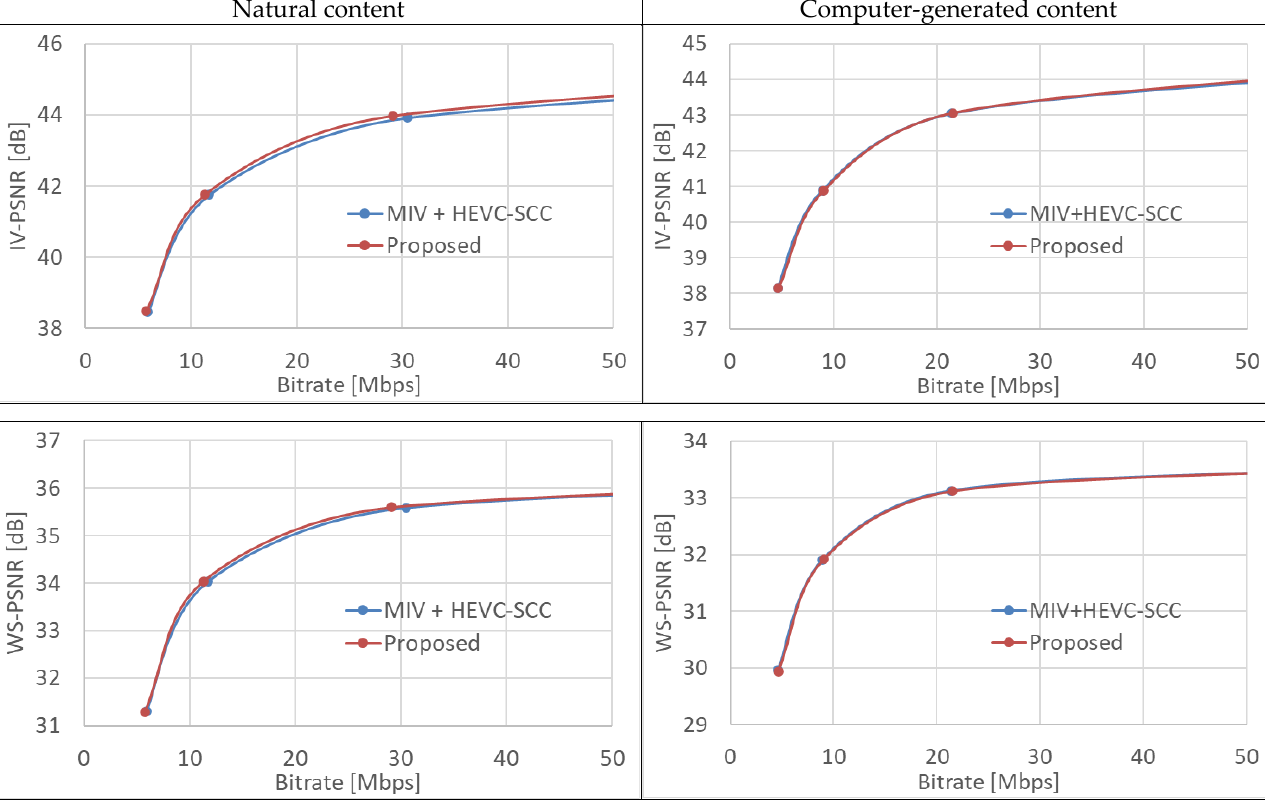
Figure 4. IV-PSNR and WS-PSNR RD-curves for natural content (left) and computer-generated content (right); comparison of basic HEVC-SCC and proposed SCC with quarter-pel IBC accuracy and tile-based IBC analysis for first texture atlas.